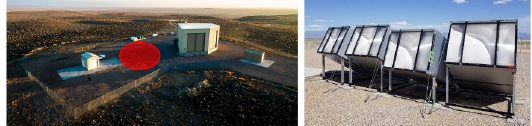
Figure 4. Prototype CRAFFT detectors were deployed next to the TA FD building as red circle. The center of field of view is pointed to the CLF.